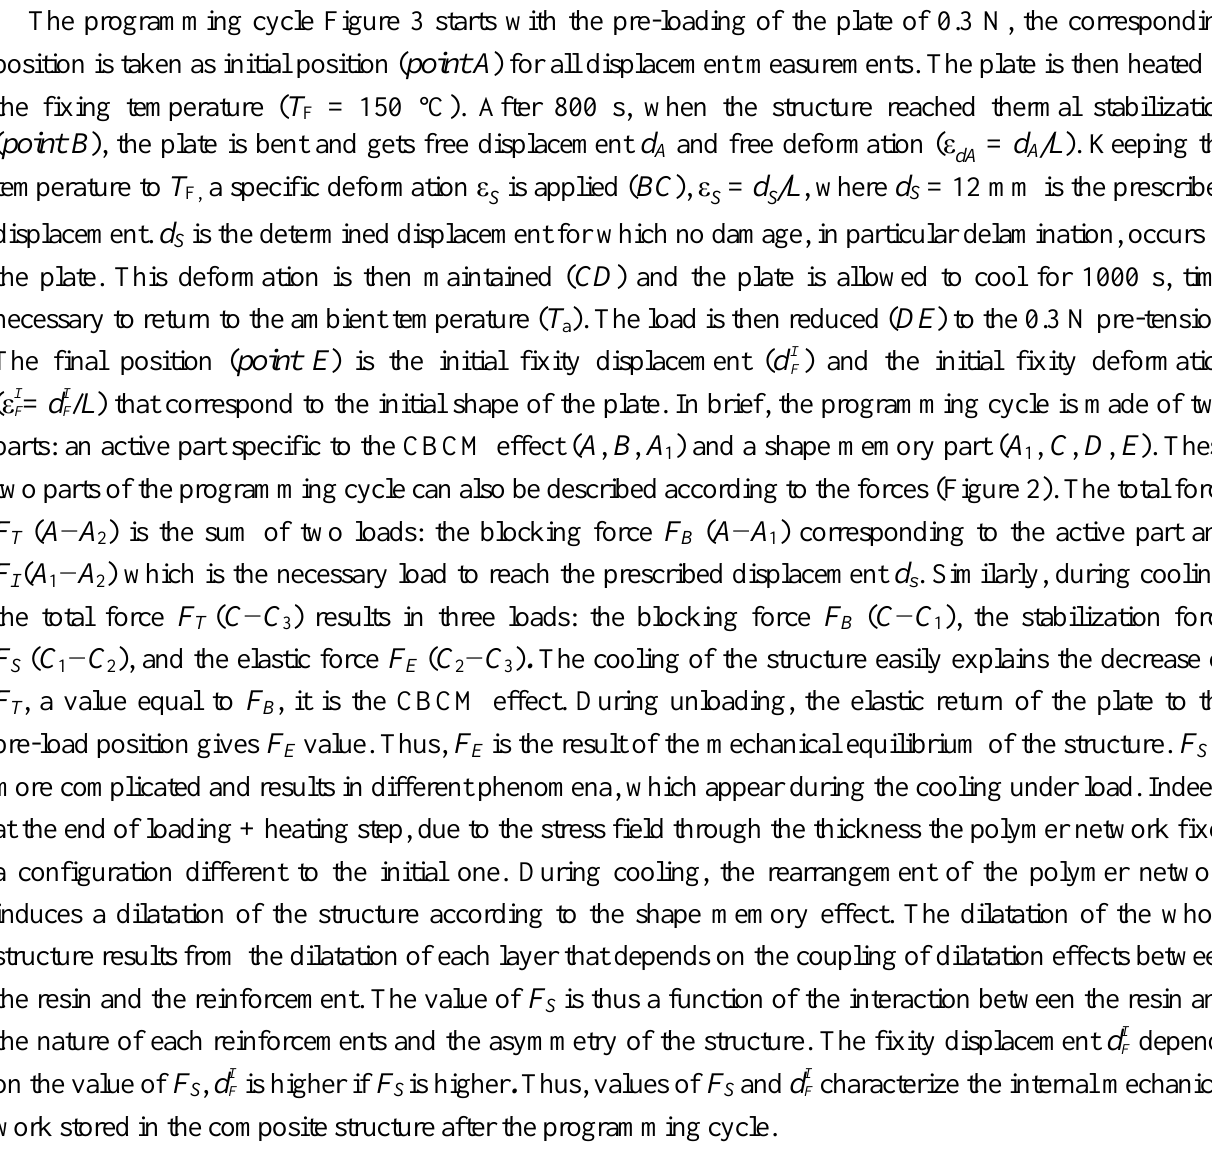
Figure 3. Example of fixing or programming cycle, fixity temperature T